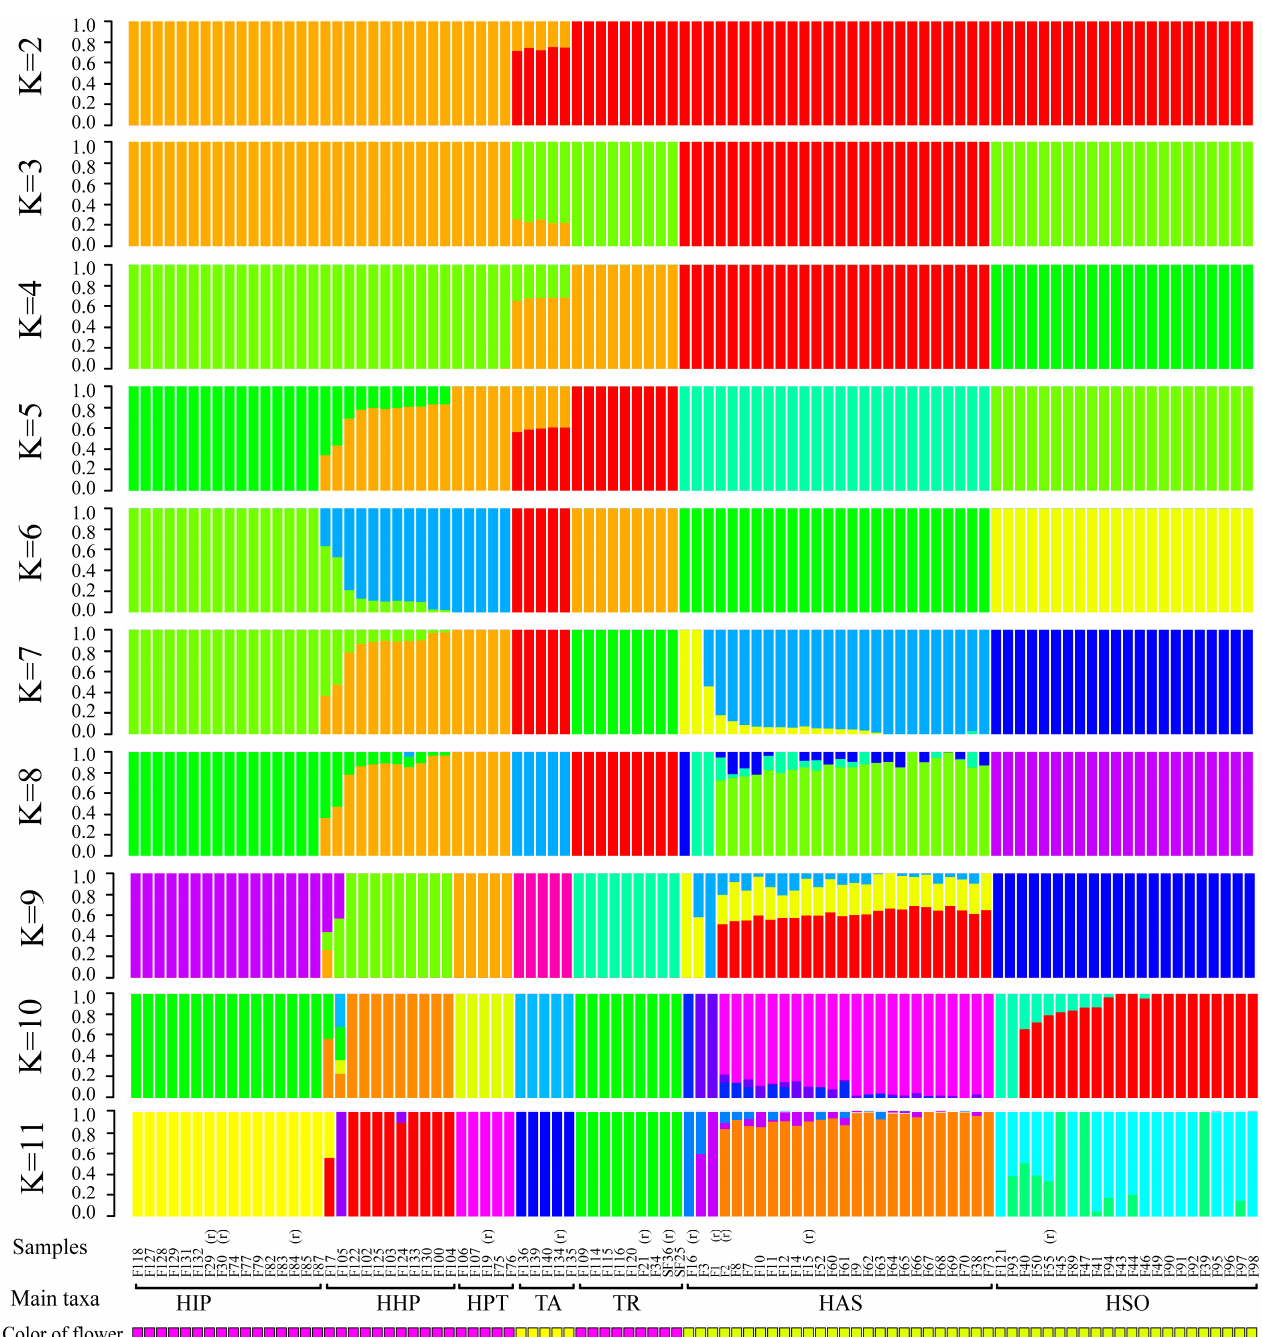
Figure 2. A structure plot of the 94 individuals from K = 2 To K = 11. (r) represent the reference samples with clear species information. HAS is abbreviation of H. chrysanthus , HSO is abbreviation of H. chrysotrichus , HPT is abbreviation of H. heptaphyllus , HIP is abbreviation of H. impetiginosus , HHP is abbreviation of Mixed traits population, TA is abbreviation of T. aurea , TR is abbreviation of T. rosea .